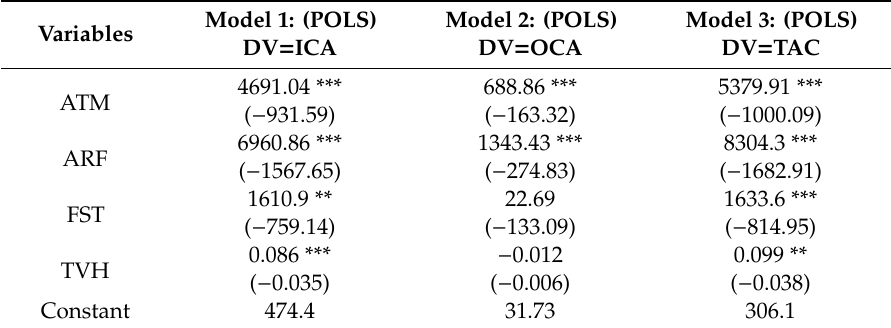
Table 2. Regression analysis for the prediction of inside-city accidents, outside-city accidents, and total accidents in relation to average temperature, average rainfall, frequency of sandstorms, and total